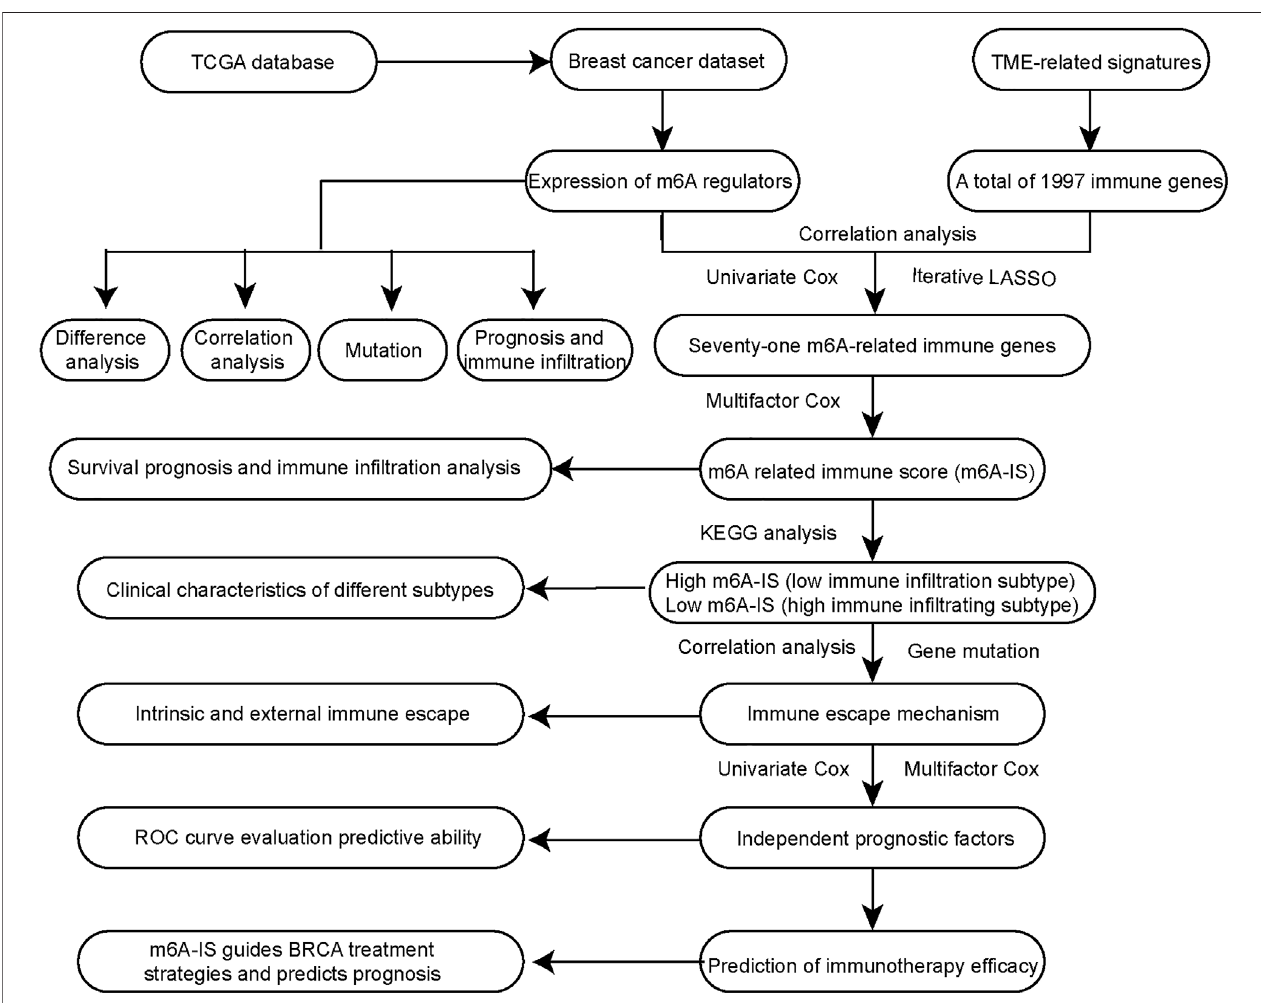
FIGURE 1 | Flowchart of the